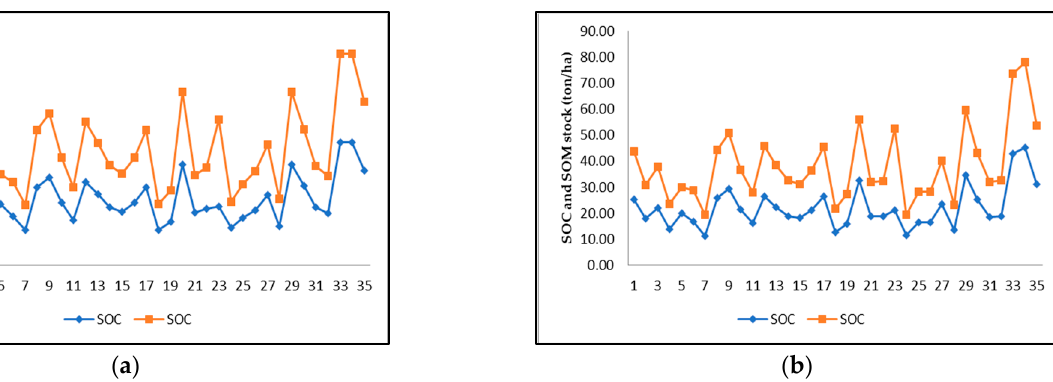
Figure 2 . Variations in SOC and SOM among stand types; ( a ) SOC concentration, ( b ) SOM concentration, ( c ) SOC stock and ( d ) SOM stock. Yellow and grey areas of the boxes indicate the second and third quartiles, respectively. Whiskers imply the upper and the lower quartile. Differ-